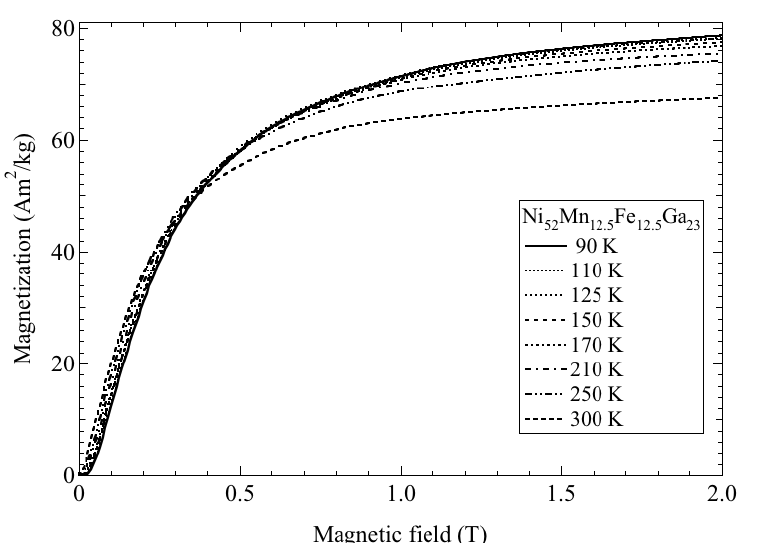
Mn Fe Ga 52 12.5 12.5 23